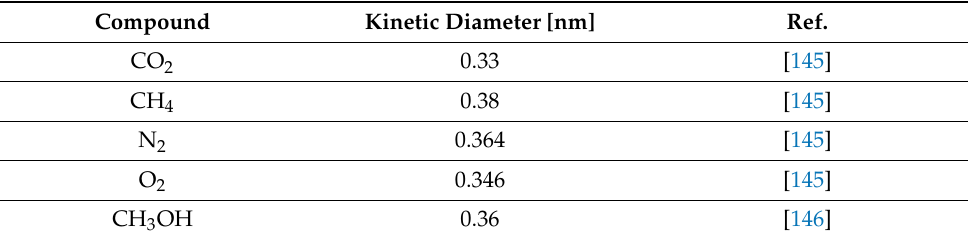
Table 3. Kinetic diameters of the